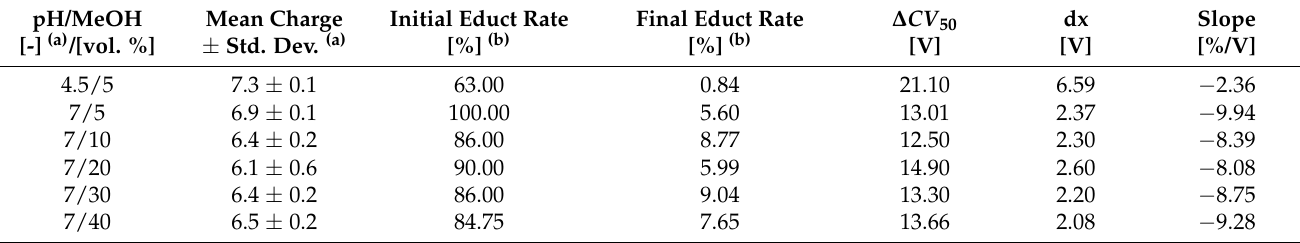
Table 1. Course parameters of gas-phase dissociation of RNAse S determined from mass